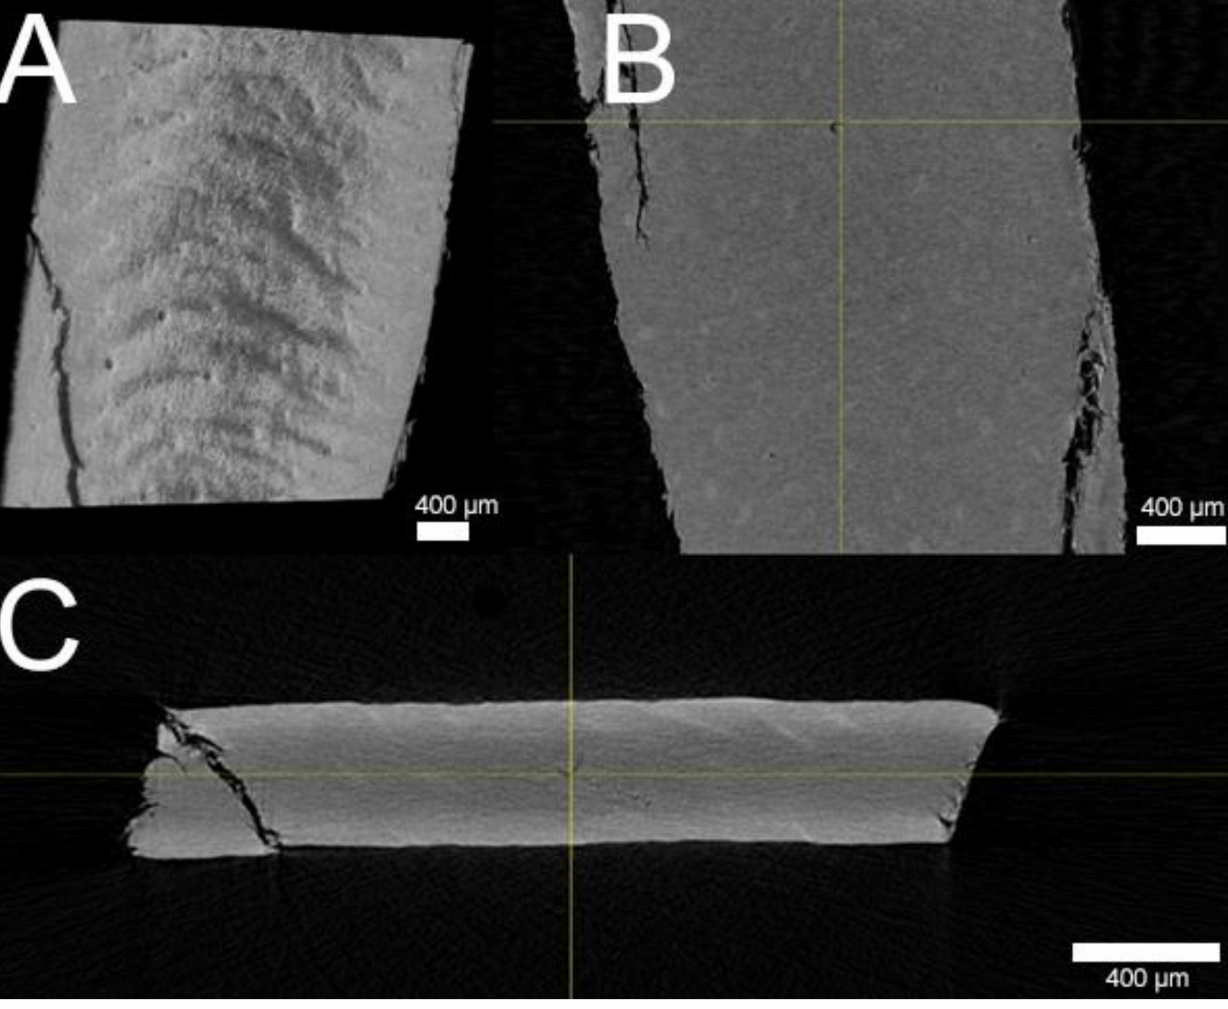
Figure 2. Volume rendering of x-ray microtomography bovine hoof sheet (BHS) images. ( A ) Surface of BHS in the Y-direction with various porous cavities visible. ( B ) Focused hollow pore (yellow cross) inside the BHS matrix in the Y-direction and ( C ) Z-direction, revealing continuation of the pore as a dark crack from the top left to bottom right; each scale bar = 400 µ